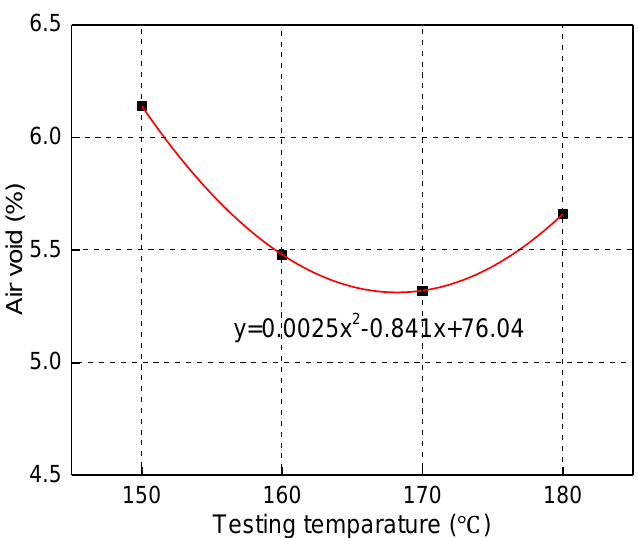
Figure 5. Relationship between the air voids and the compaction temperatures.